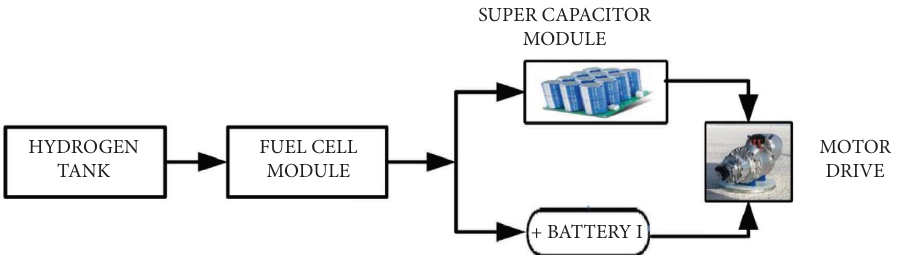
Figure 7: An ER-FC confguration block diagram.